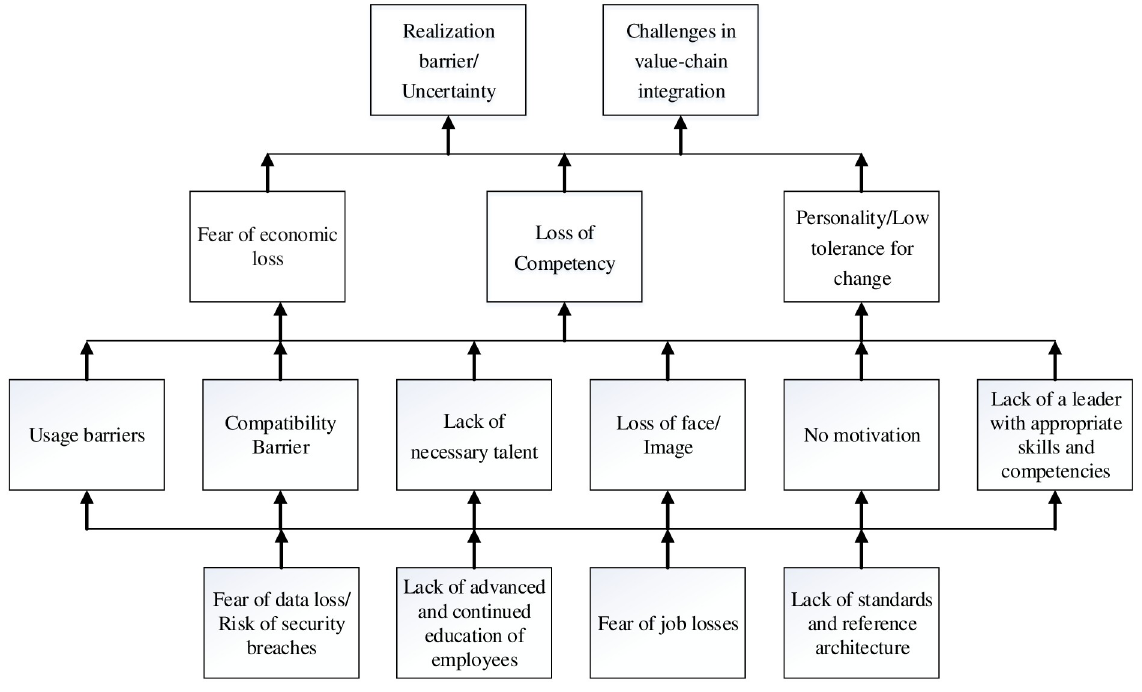
Fig 3. The hierarchical structure of